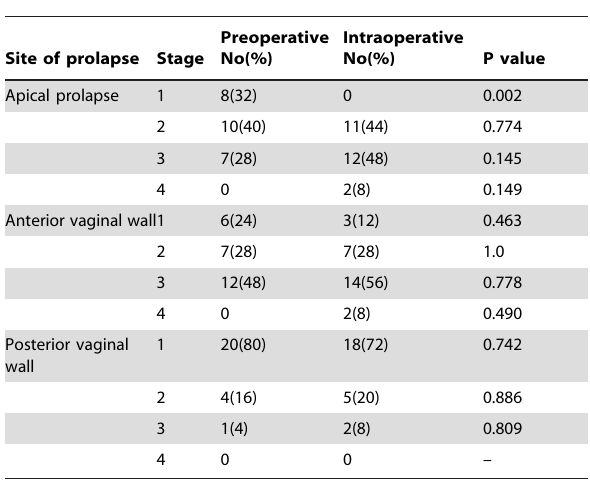
Table 3. Stage of prolapse with Valsalva maneuver preoperatively and under general anesthesia with uterine traction